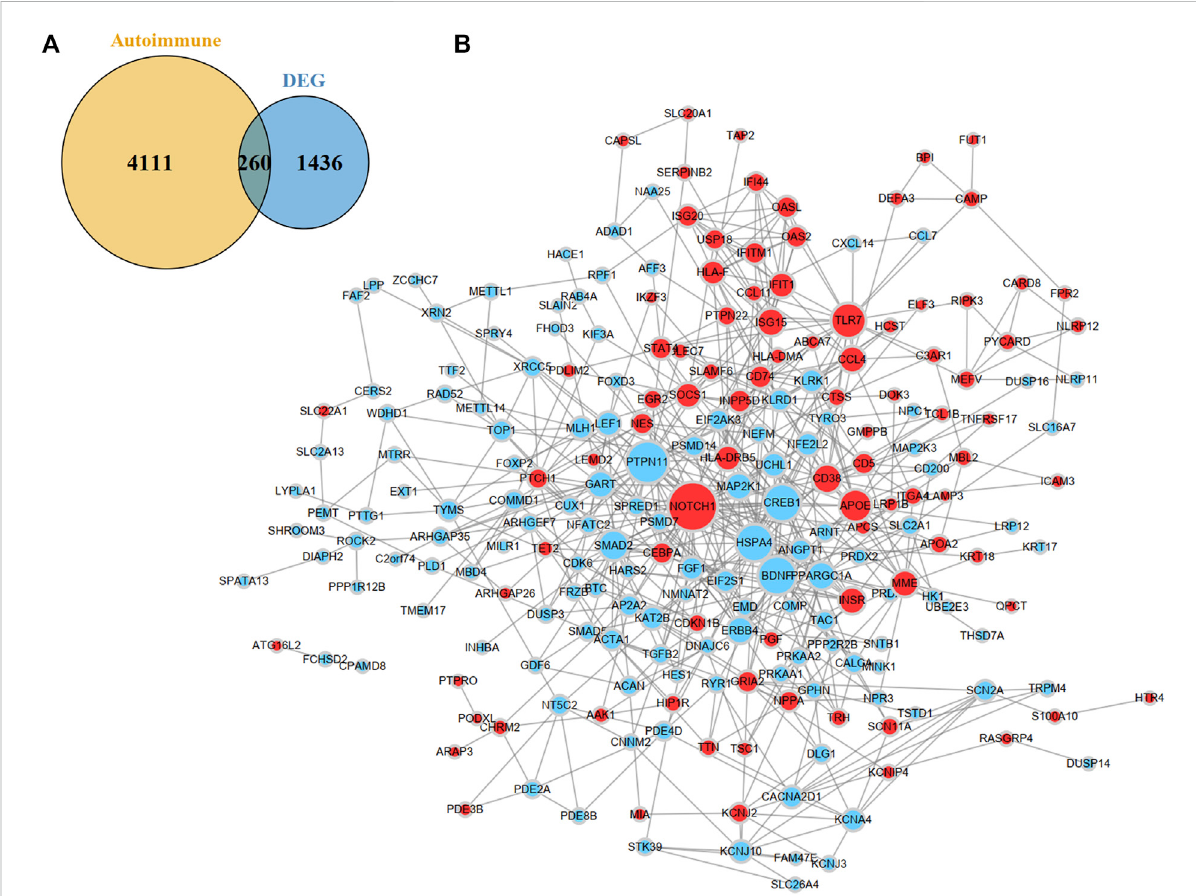
FIGURE 4 Identi fi cation andPPI network construction ofDEARGs. (A) A vennplotshow 260DEARGsinMMD. (B) PPI network of DEARGs. Thebluenodes represent the down-regulated genes and the red nodes represent the up-regulated genes. The dot size indicates the degree of the nodes. DEARGs, differentially expressed autoimmune-related